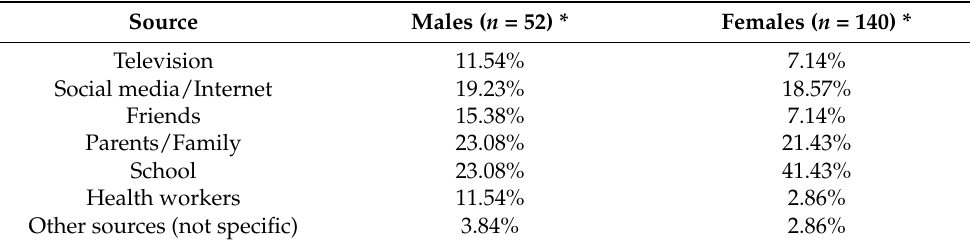
Table 2. Where the respondents heard/learned about